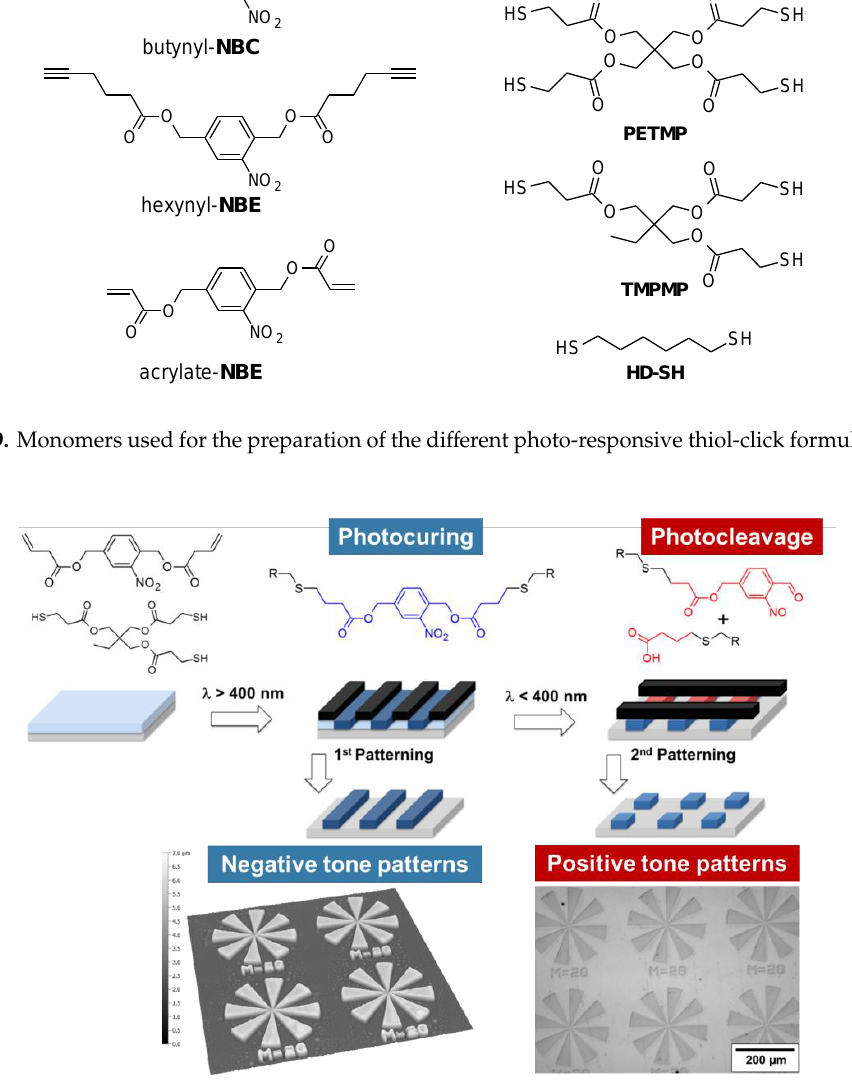
Figure 10. Photo-induced formation and light triggered cleavage of thiol-ene networks for the design of switchable polymer patterns. (Adapted from reference [117] published by the Royal Society of Chemistry).